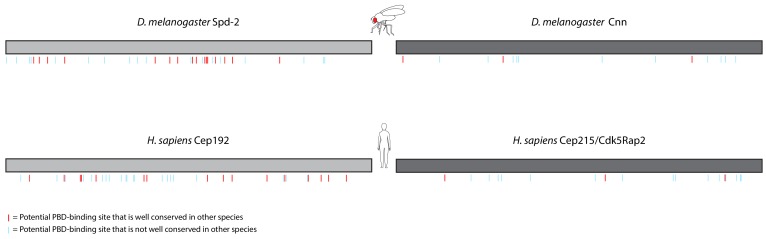
Distribution of S-S/T motifs in Spd-2/Cep192 and Cnn/Cep215 protein families.Schematic representation of the amino acid sequences of D. melanogaster Spd-2 (1146aa) and H. sapiens Cep192 (isoform 1, 1941aa) (light grey), and D. melanogaster Cnn (1148aa) and H. sapiens Cep215/Cdk5Rap2 (1893aa) (dark grey). Because these proteins have different numbers of amino acids, the cartoons have been normalised to the same length for ease of comparison. The position of each S-S/T motif (potential PBD binding site) is indicated with lines underneath each cartoon: red lines indicate potential PBD-binding sites that are conserved in at least 11 of 12 Drosophila species or eight of nine mammalian species; light blue lines indicate sites that are less well conserved. Note that the fly and human homologues of Spd-2/Cep192 and Cnn/Cep215 share little sequence identity (~23% and ~24%, respectively), yet the number and overall distribution of potential PBD binding sites is quite similar. Note also that we use Isoform 1 of Cep192 in this comparison, but similar results are obtained with the longer isoform 3 (2537aa), and an analysis of both isoforms is included in the MSAs shown in the accompanying data files.10.7554/eLife.50130.011Figure 2—figure supplement 1—source data 1.Cep192 (isoform 3) sequence alignment.10.7554/eLife.50130.012Figure 2—figure supplement 1—source data 2.Cep192 sequence alignment.10.7554/eLife.50130.013Figure 2—figure supplement 1—source data 3.Cep215 sequence alignment.10.7554/eLife.50130.014Figure 2—figure supplement 1—source data 4.Cnn sequence alignment.